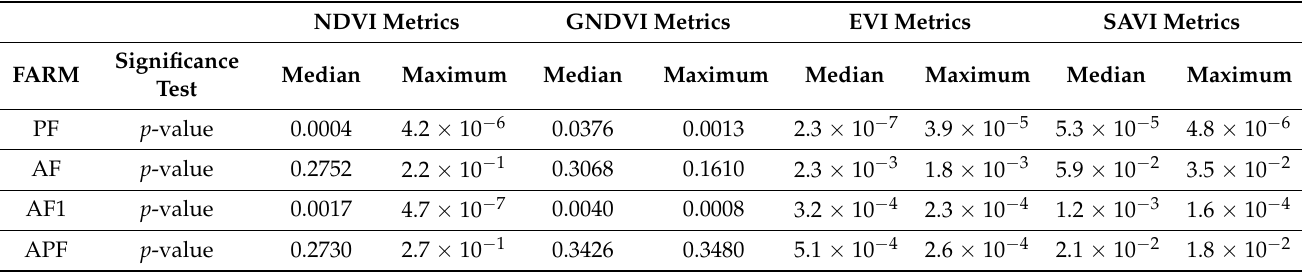
Table 2. Results of a Single-Factor analysis of variance (ANOVA) of phenology stages within the four farms.